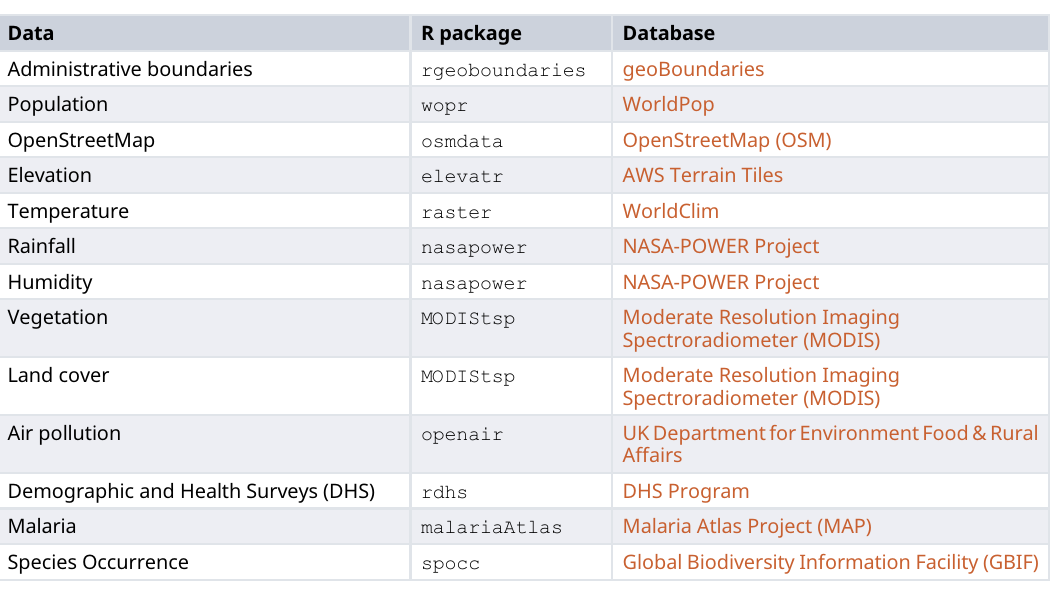
Table 1. All the datasets included in the rspatialdata website and databases and R packages that can be used to retrieve